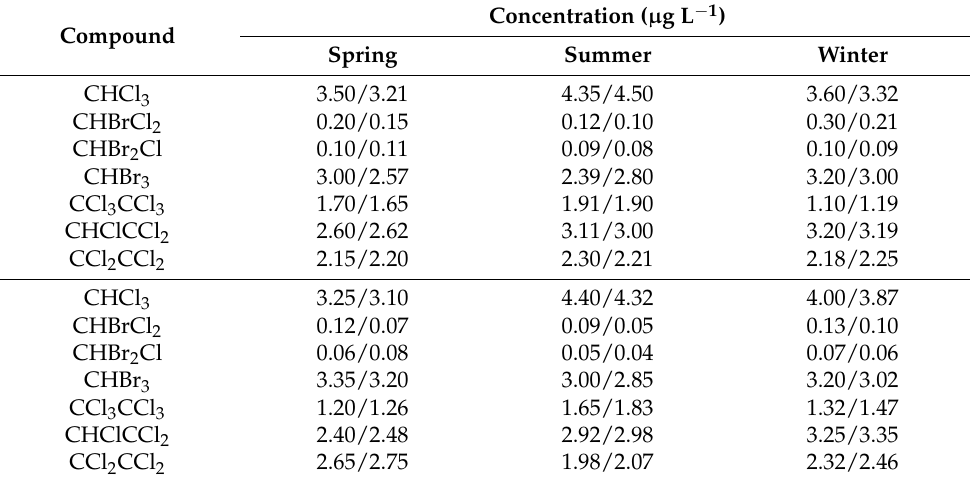
Table 3. Organohalogens in the Marta River samples (n. 24) during different seasons in 2015 and 2016. For each compound are reported the levels determined by the two analytical procedures (headspace analysis (HS)-gas chromatography-electron capture detector (GC-ECD)/liquid–liquid extraction (LL)-GC-ECD).